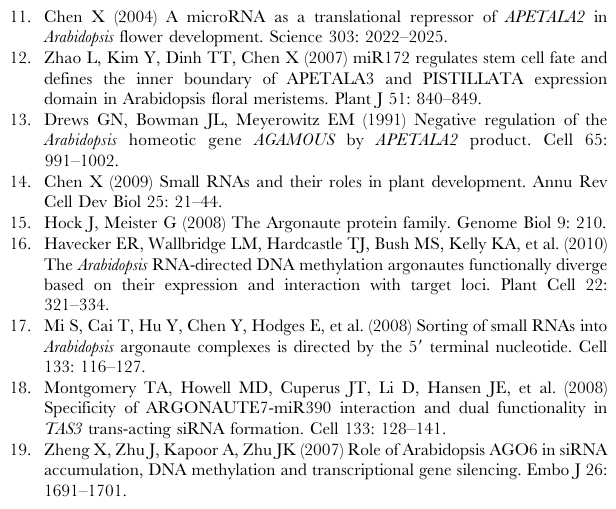
Figure S4 AGO10 does not bind miR390. Northern blots for miR166 and miR390 were performed for total RNAs from wild type (L er ; the three lanes on the right) and immunoprecipitated samples (the first two lanes from the left) using anti-GFP antibodies from L er (a negative control) and the YFP-ZLL transgenic line.